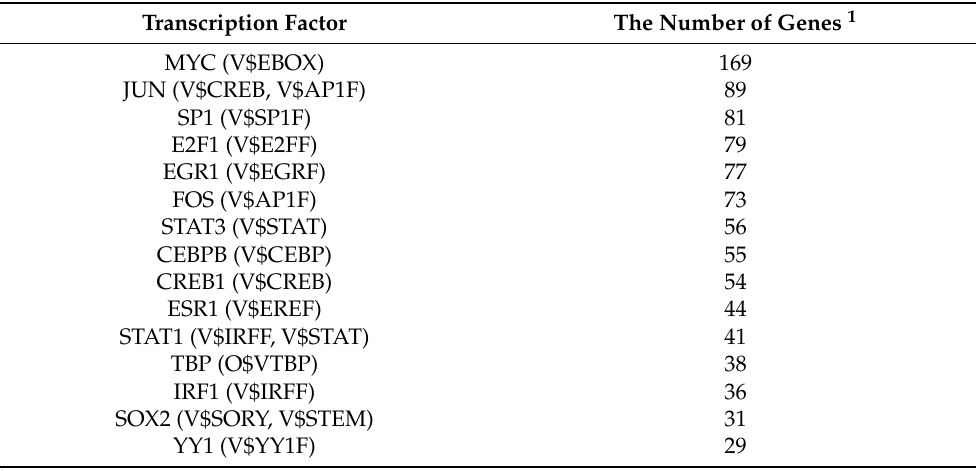
Table 1. The top 15 transcription factors ranked by the number of regulated genes, whose expression changed significantly by RP11-1023L17.1